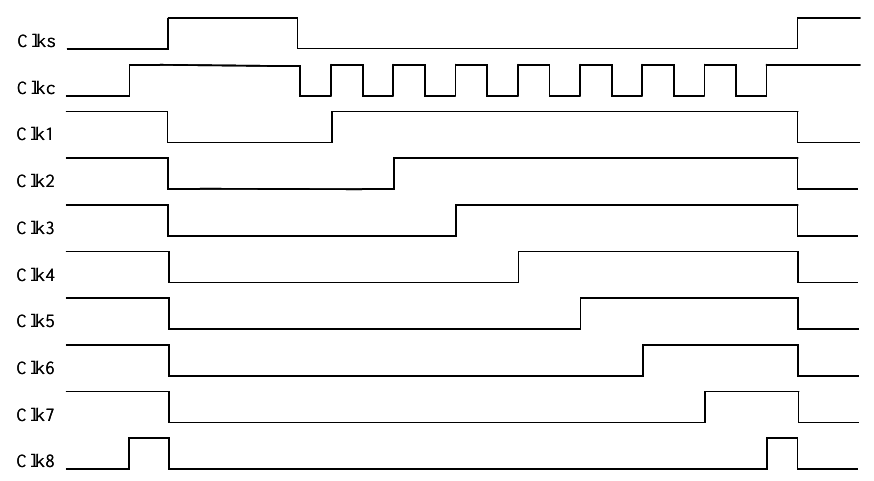
Figure 14. Timing diagram of asynchronous control logic.